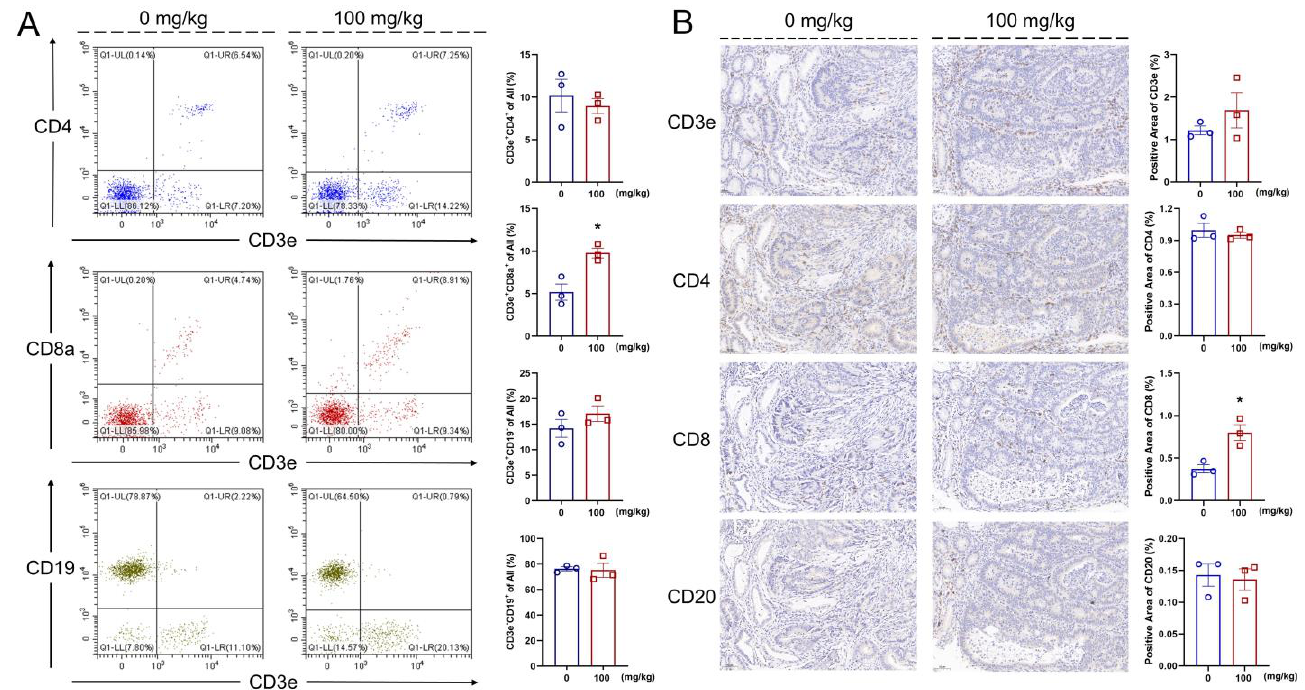
Figure 4. IHS enhanced the abundance of CD8 + T cell. IHS enhanced the abundance of CD3e + CD8a + T cells and no significant change in the abundance of CD3e + CD4 + , CD3e + CD19 − , and CD3e − CD19 + cell in blood ( A ); IHS enhanced the positive area of CD8 and does not significantly change the positive area of CD3e, CD4, CD20 in tumor ( B ) ( n = 3; 20 × , 50 µ m). Data were analyzed using a one-way ANOVA and are shown as means ± SEM. * p < 0.05, vs. vehicle-treated mice.